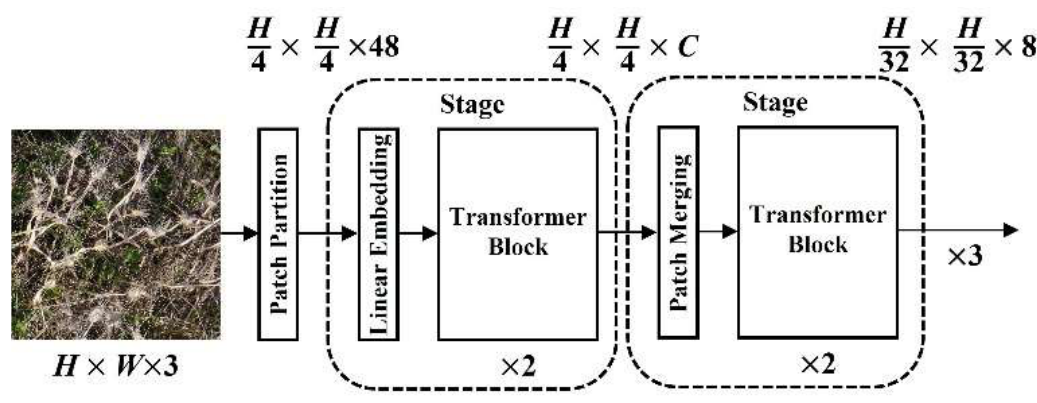
Figure 4. The architecture of Transformer.